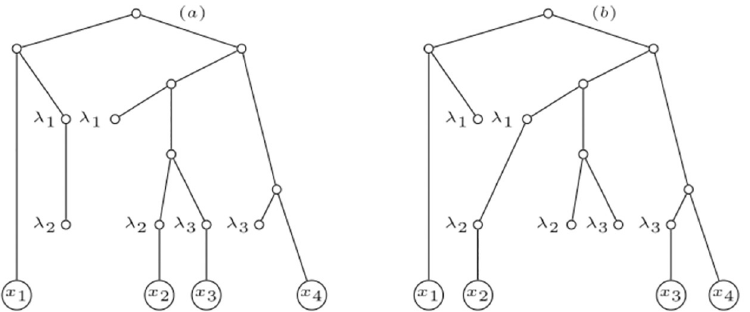
Fig 8. Subtrees of U ( N ). Let N be the internally labelled phylogenetic network depicted in Fig 1. The figure depicts two (IMLT) subtrees of U ( N ).